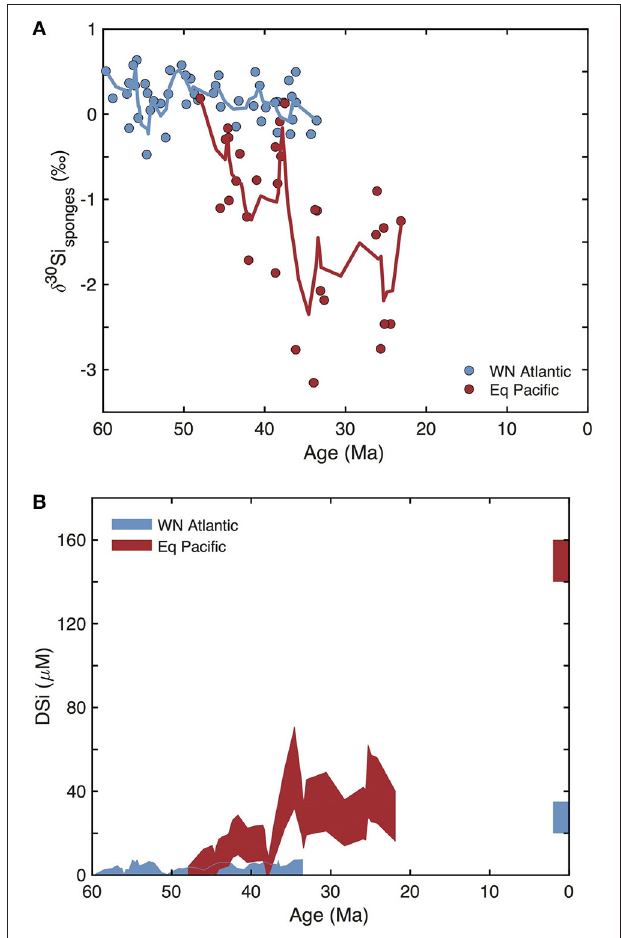
FIGURE 4 | (A) The range of δ 30 Si of sponges from deep-sea drilling cores (Fontorbe et al., 2016, 2017). (B) The range of DSi concentrations in the Western North Atlantic (blue) and in the Equatorial Pacific (red) reconstructed from the δ 30 Si of sponges and radiolarians from deep-sea drilling cores ( Fontorbe et al., 2016, 2017). The blue and red bars for present time represent the modern DSi concentration in the bottom waters of both ocean